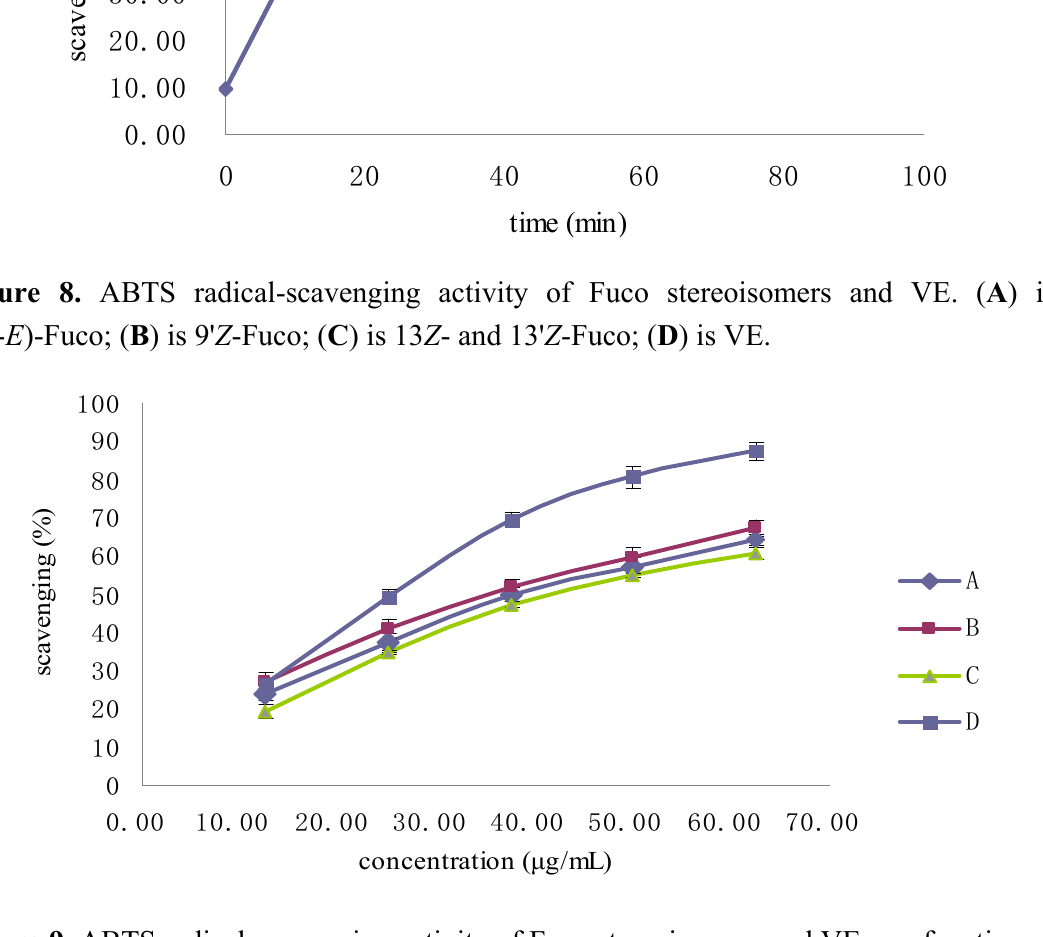
Figure 9. ABTS radical-scavenging activity of Fuco stereoisomers and VE as a function of their EC . ( A ) (all- E )-Fuco; ( B ) 9' Z -Fuco; ( C ) 13 Z - and 13' Z -Fuco; ( D ) 50s